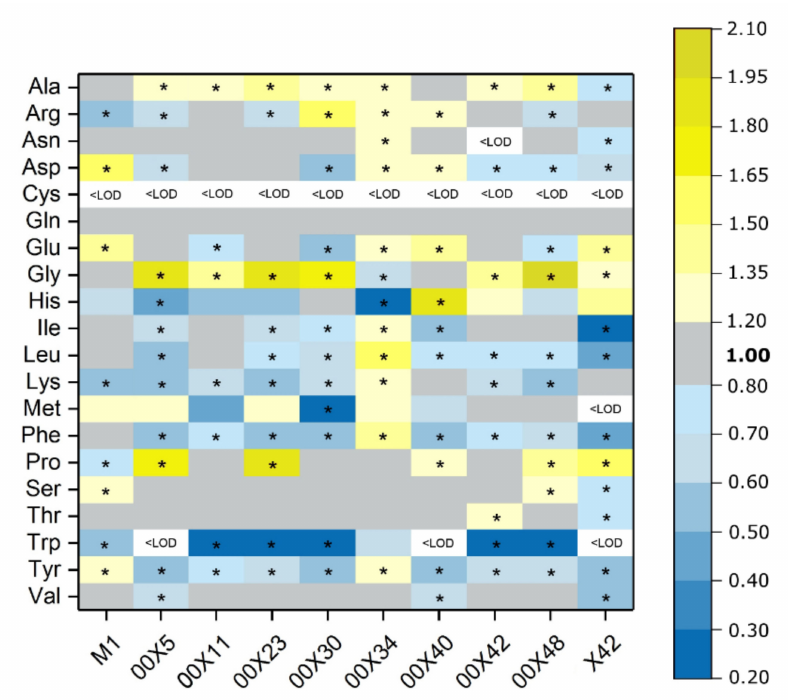
Figure 7. Free amino acid content in the rapeseed leaves. The contents of individual amino acids of all samples are expressed in % of total amount (dry weight) and compared with those of the control (untreated rapeseed plants). Each code (00X5, 00X11, 00X23, 00X30, 00X34, 00X40, 00X42, 00X48, X42, and M1) represents rapeseed plants treated with a Pythium strain. Asterisks denote significant di ff erences ( p ≤ 0.05) between sample and control plants according to t -test. < LOD, under the limit of